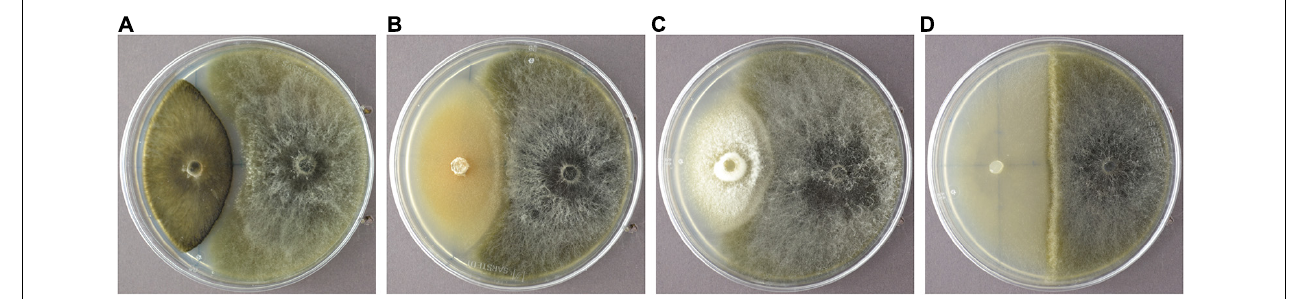
FIGURE 4 | Sydowia polyspora (A) , Microsphaeropsis olivacea (B ), Truncatella conorum-piceae (C) , and Desmazierella acicola (D) were the endophytes chosen for the infection experiment. TABLE 4 | Frequency as percent of twig-inhabiting fungal endophytes isolated from two-year-old Pinus sylvestris . Pine